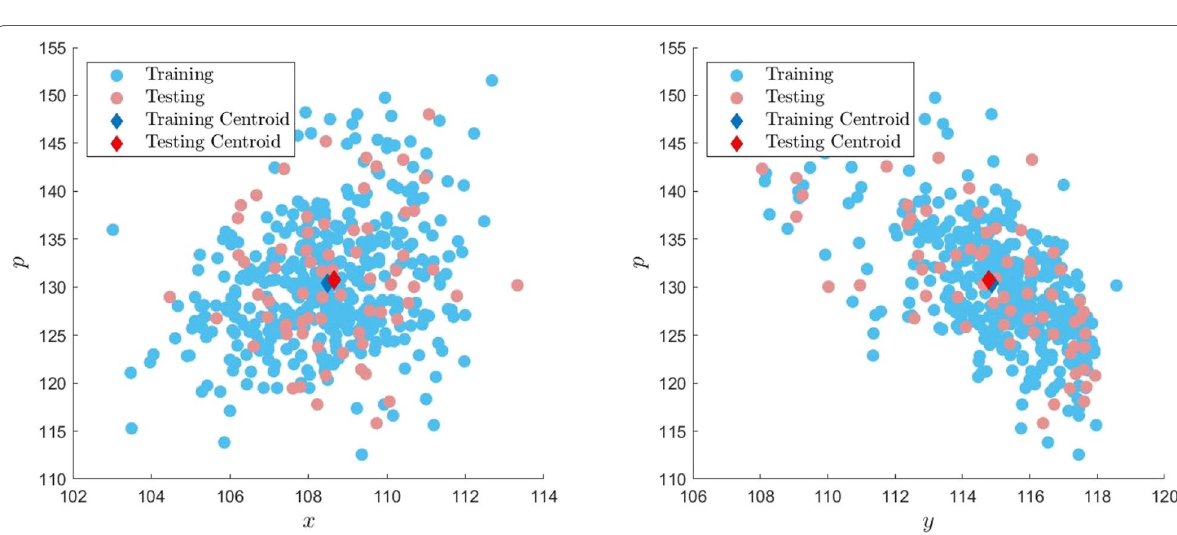
Fig. 12 Comparison of clusters for training and testing datasets for wooden